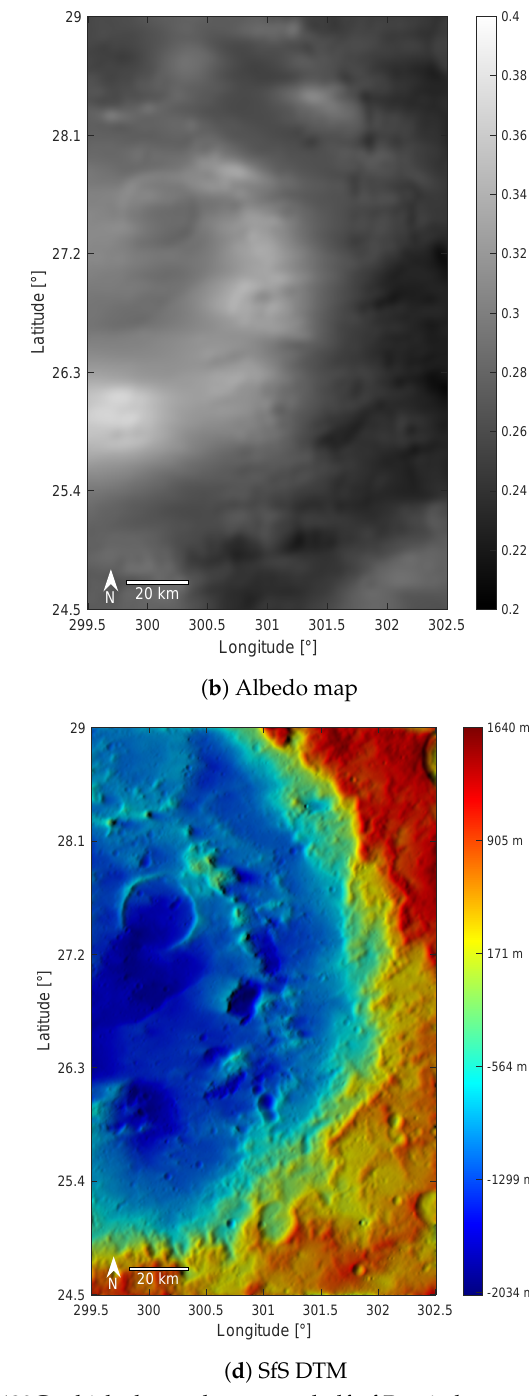
Figure 7. ( a ) Part of MDIS-WAC image EW1048451439G which shows the eastern half of Praxiteles crater with bright hollows (yellow arrows) and a bright pit-crater (white arrow) on the inner ring. The strong albedo variations impose a significant challenge to the SfS method. ( b ) Final albedo map. The high albedo of the hollows and the pit crater are particularly evident as they are much brighter than the outer basin rim. ( c ) Color-coded initial DTM from Becker et al. [24]. ( d ) Color-coded SfS